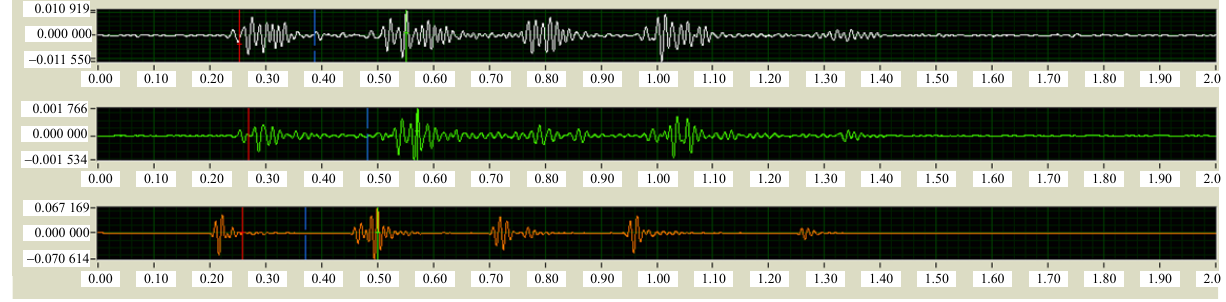
Fig. 10 Typical micro-seismic event.